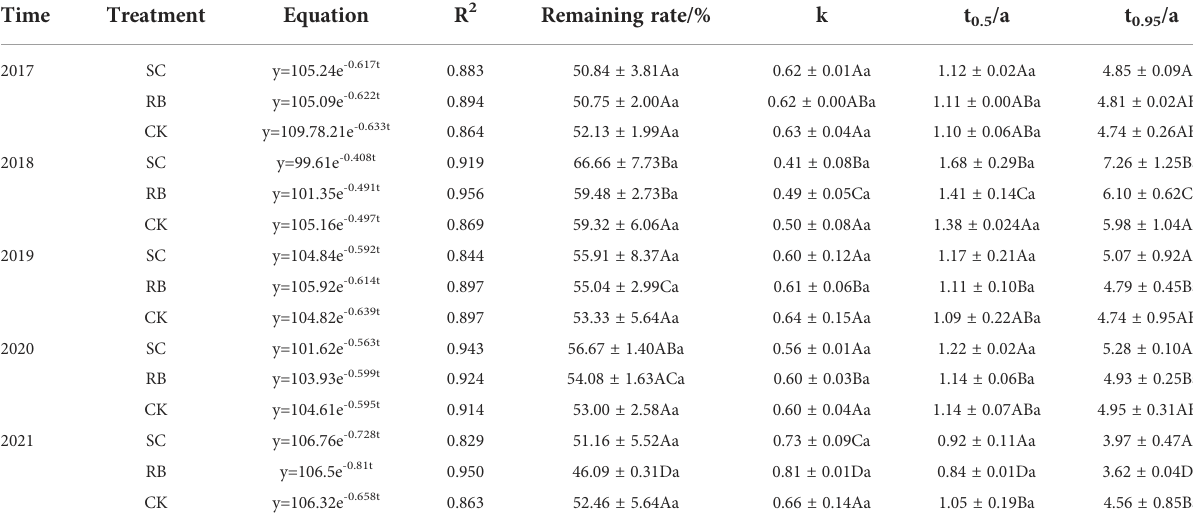
Values are the mean ± standard deviation (n=3). Different lowercase letters indicate a signi fi cant difference in litter decomposition parameters between the different treatment plots at the same time (p< 0.05); Different capital letters indicate a signi fi cant difference in litter decomposition parameters between the different times in the same treatment plot (p< 0.05).